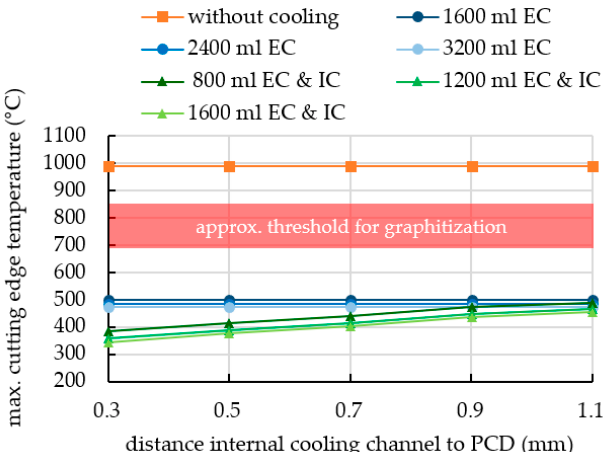
Figure 3. FSI-Simulation results.